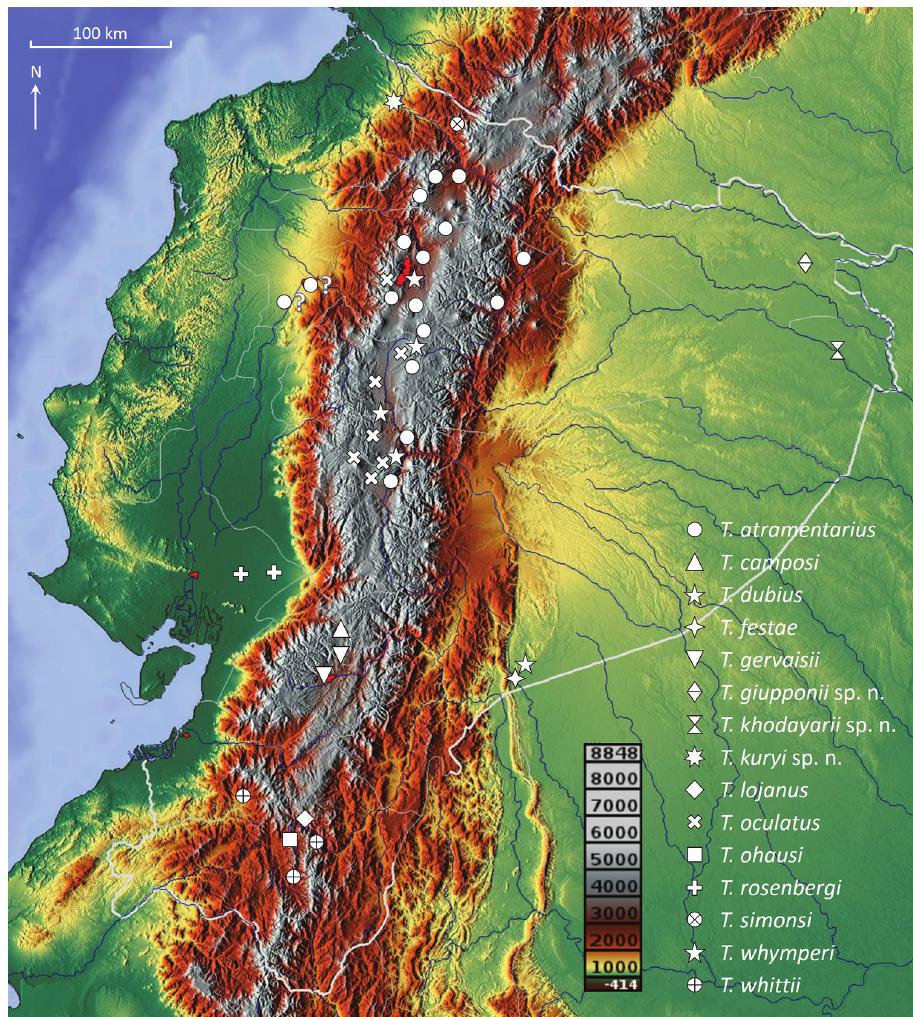
Figure 1. Topographic map of Ecuador showing the distribution of the known species of Teuthraustes